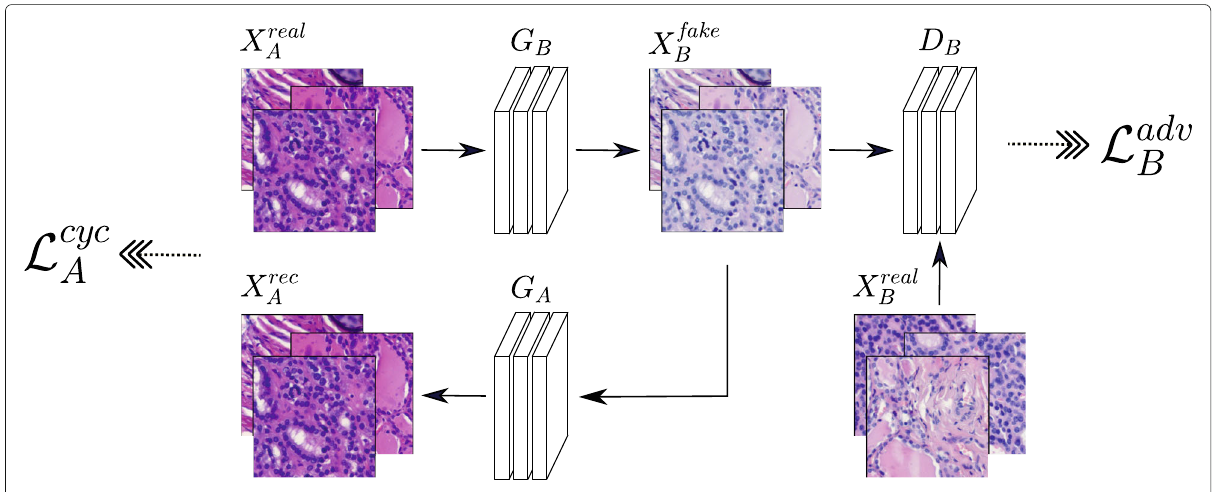
Fig. 1 Illustration of the applied CycleGAN architecture for mapping images from domain A to domain B . is mapped to domain B by the generator G B : X real A real sample image X real A